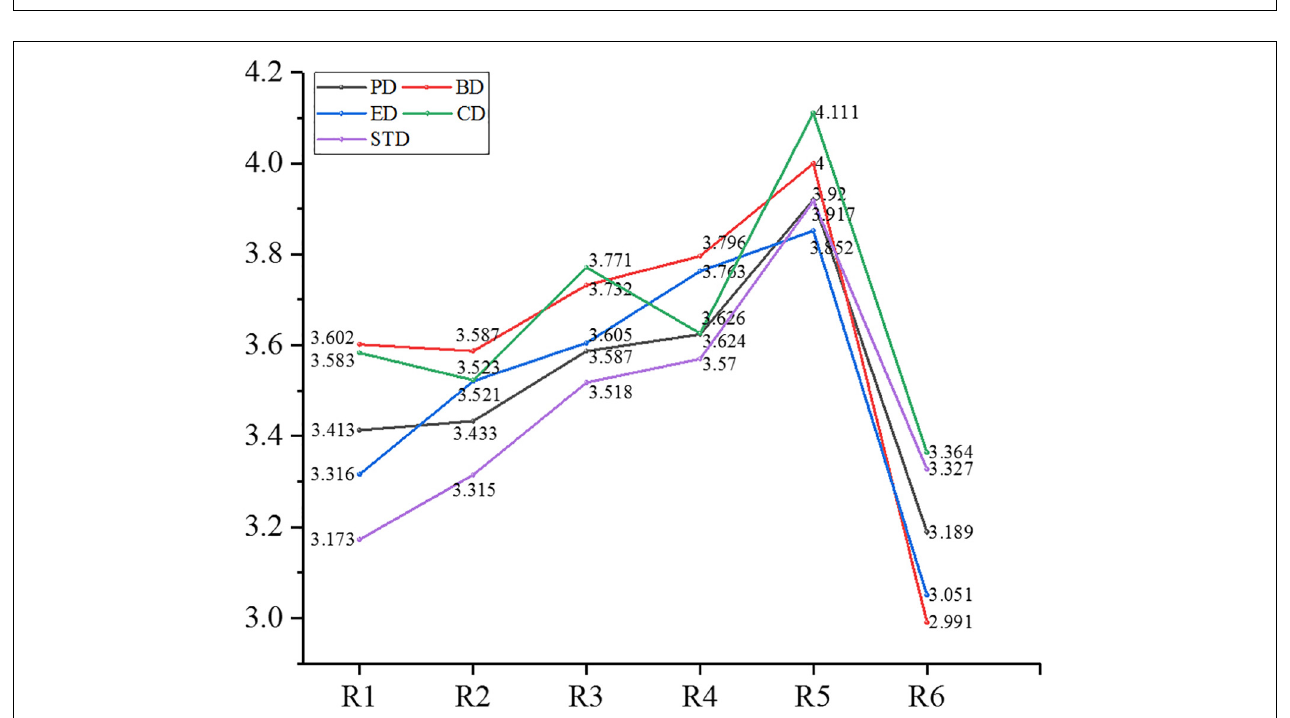
FIGURE 10 | Mean value of Psychological distance and dimensions thereof in the residential